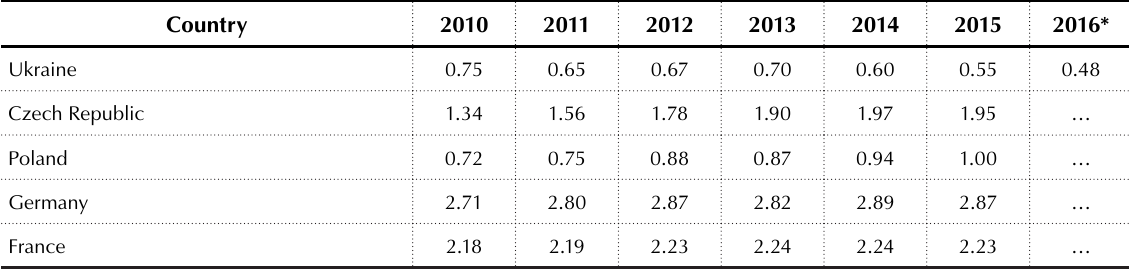
Table 7. Research and development costs, % to GDP